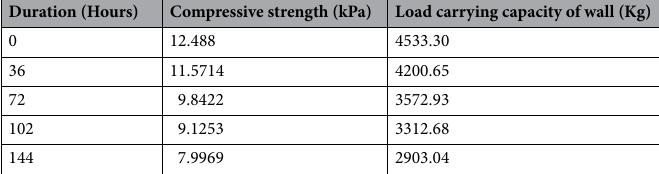
Table 2. Compressive strength and load-carrying capacity of wall sections for each